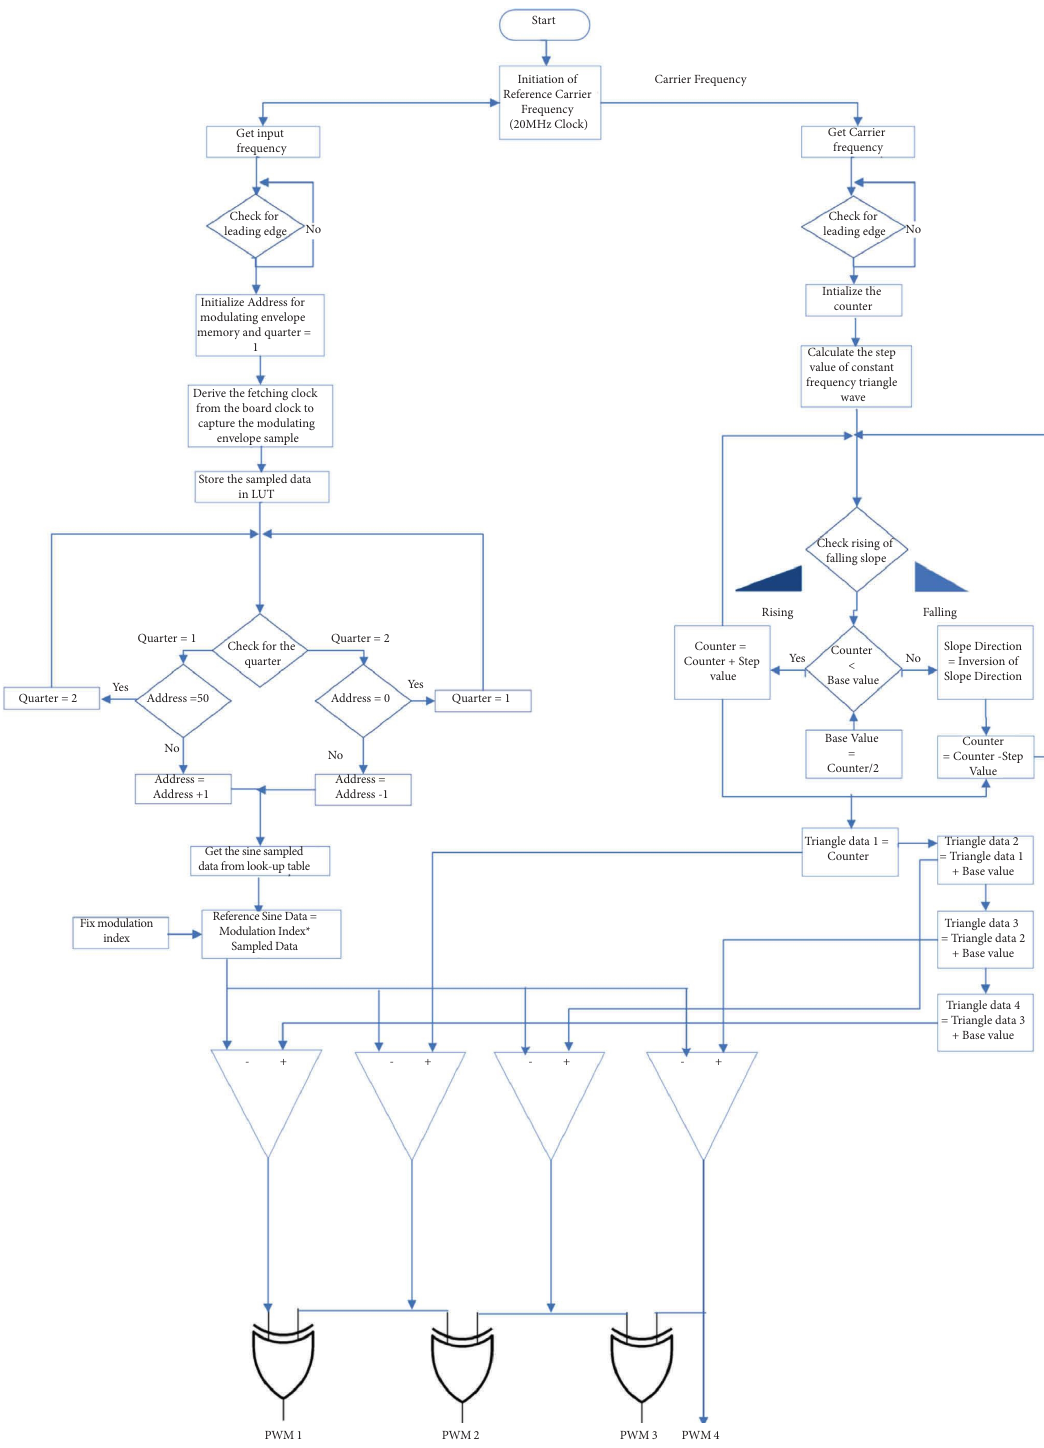
Figure 21: Flowchart for FPGA